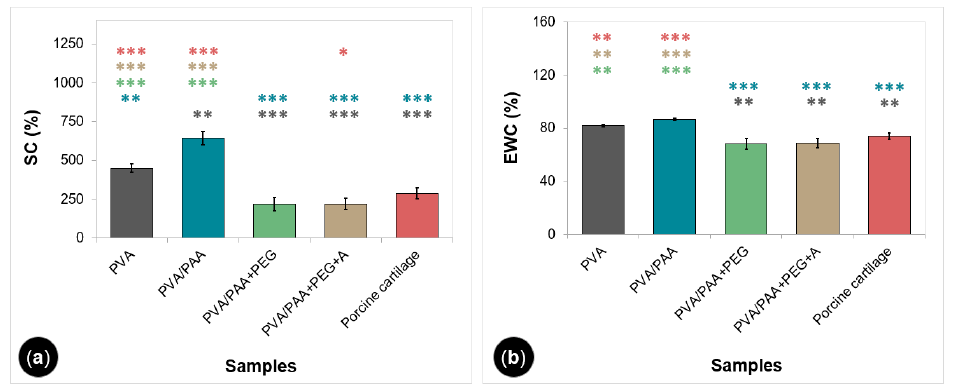
Figure 2. Swelling capacity ( a ) and equilibrium water content ( b ) of the hydrogels and porcine cartilage. Error bars are the ± standard deviations, n = 3. Data were analyzed using ANOVA ( p < 0.0001) and Tukey’s HSD test. Statistical differences are indicated by asterisks (* p < 0.05, ** p < 0.005, *** p < 0.0005).